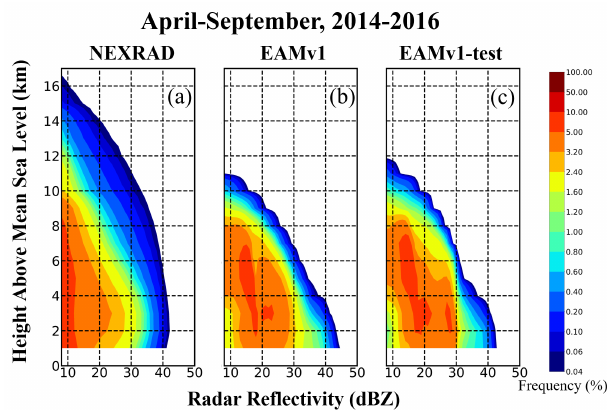
Figure 8. Comparison of contoured-frequency-by-altitude dia- grams (CFADs) for the warm seasons over 2014–2016 between (a) NEXRAD, (b) EAMv1 simulation, and (c) the EAMv1-test sim- ulation with reduced convective entrainment